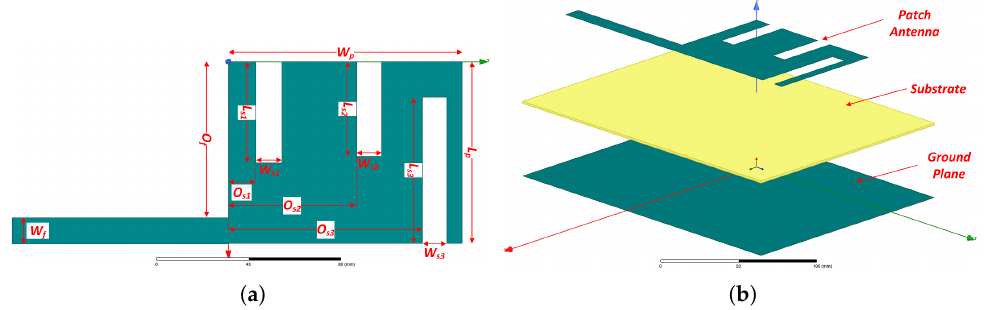
Figure 2. Geometry of the proposed modified E-shaped patch antenna: ( a ) top view (the decision variables of the optimization process are indicated, substrate and ground plane are omitted in this view), ( b ) expanded perspective